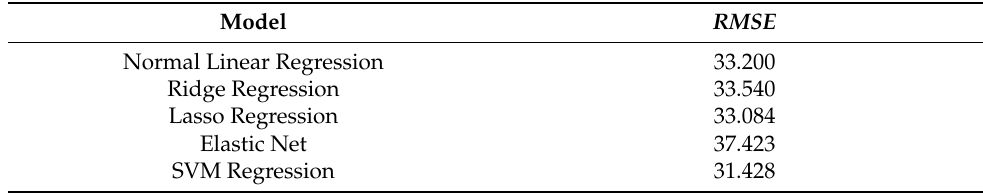
Table 3. RMSE s from model